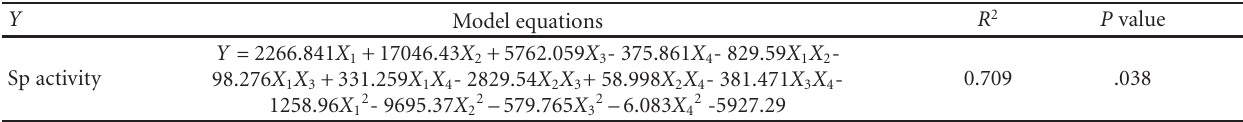
Table 6: The model equations for kinetic parameters.